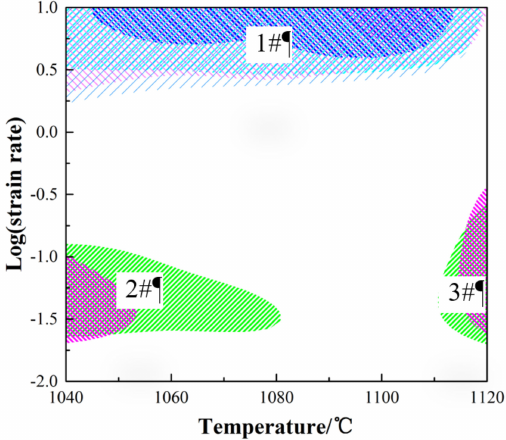
Figure 10. The processing map under different